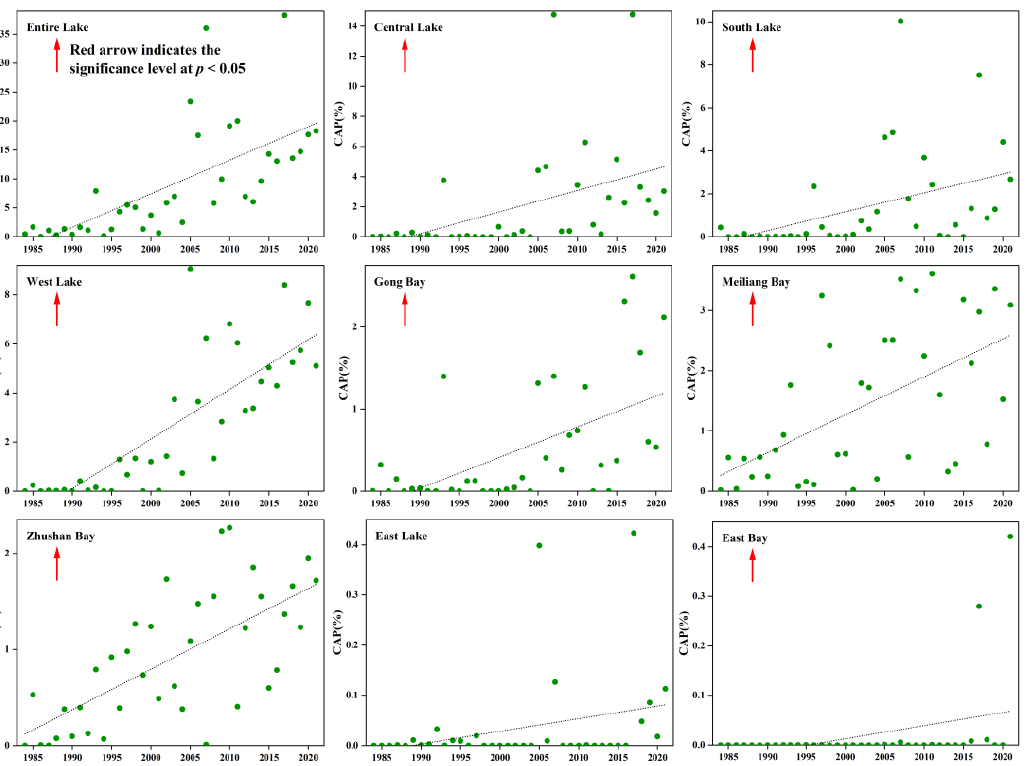
Figure 7. Annual cyanobacterial bloom area percentage for the entire lake and each segment. The arrows indicate that the CAP values showed a significant ( p < 0.05) increasing trend over 38 years.